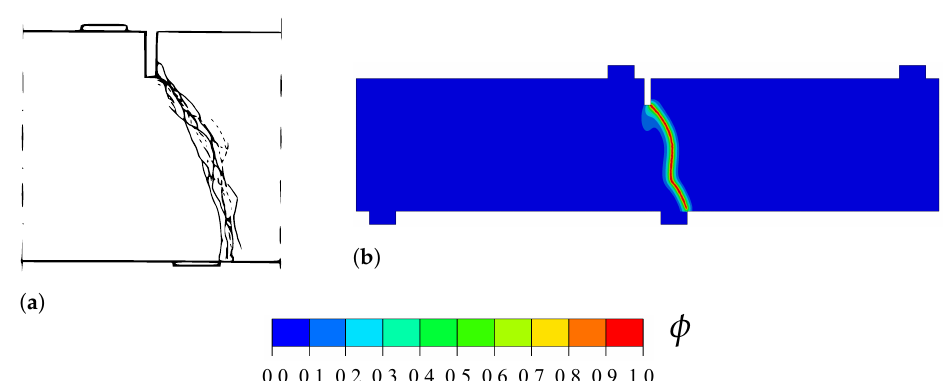
Figure 5. Mixed-mode fracture of a concrete beam: ( a ) Experimental crack patterns [51], and ( b ) predicted crack trajectory, as given by the phase field